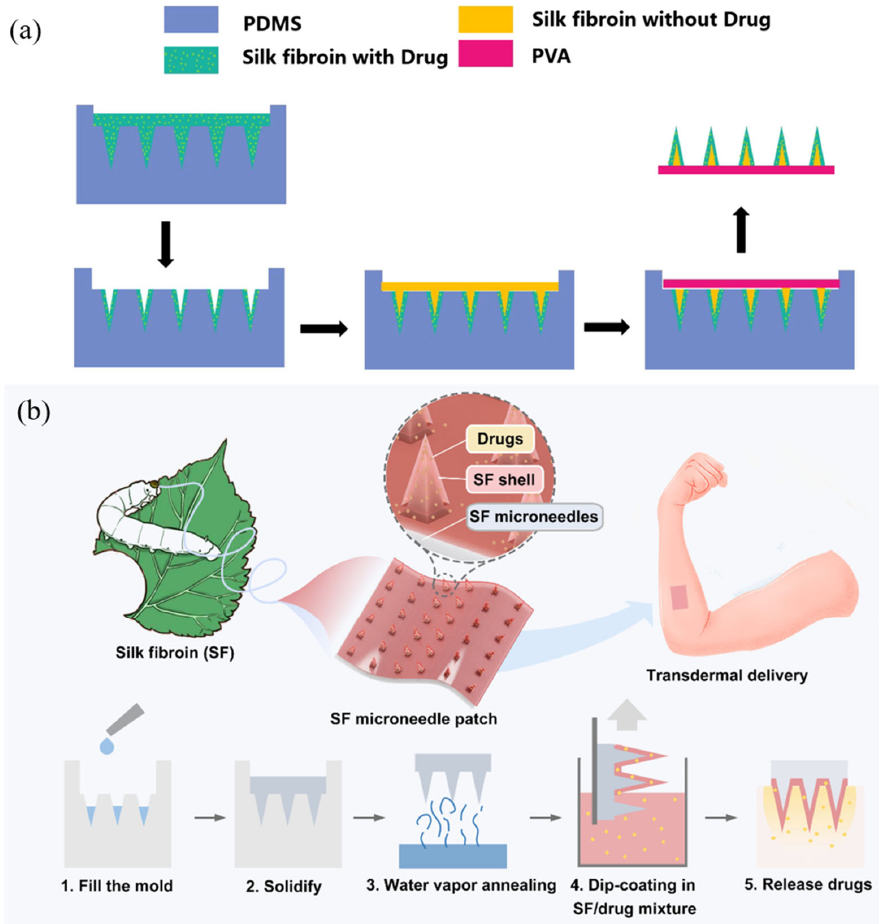
Figure 4. ( a ) Schematic diagram of composite dissolved microneedles: drug-loaded silk fibroin protein is used as the tip of the outermost layer, drug-free silk fibroin protein as the second layer, and PVA as the base; ( b ) Schematic diagram of the production of double-layer silk fibroin microneedles: the silk fibroin solution containing glutaraldehyde is poured into the PDMS mold, and after drying, steam annealing treatment takes place, and the silk fibroin solution is soaked in medicine on the surface of the dry microneedles. Image used with permission of [82,87].